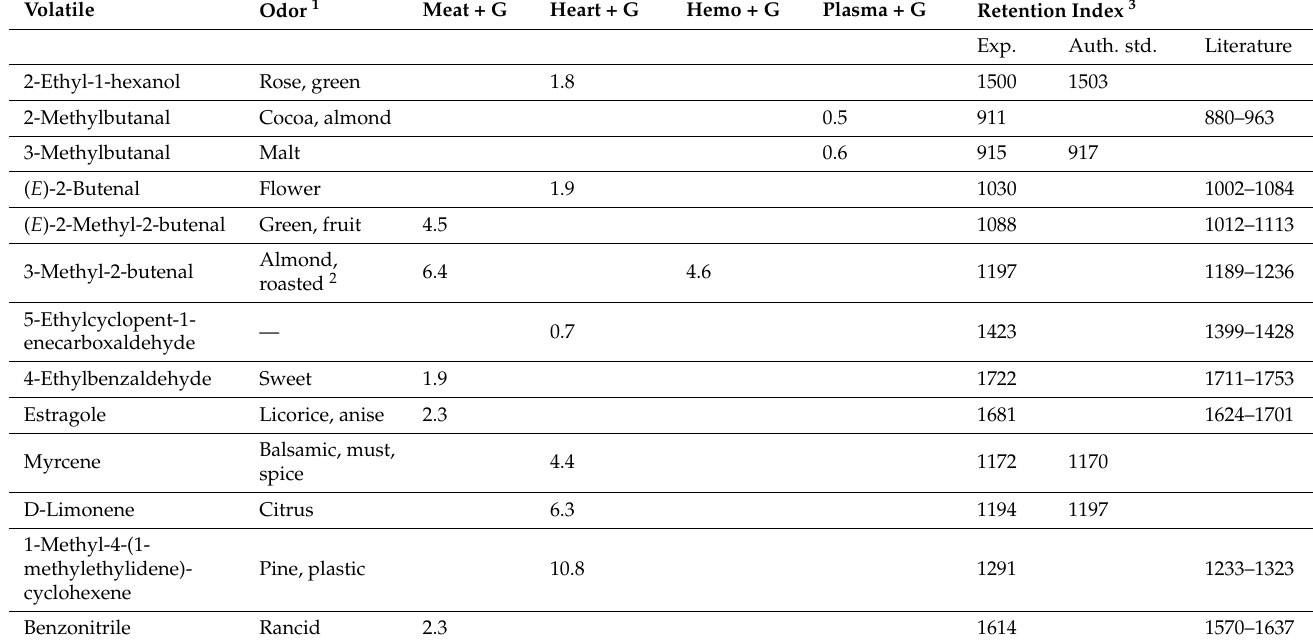
Table 3. Volatile compounds where glucosamine (G) addition had an effect on quantities present in the hydrolysates. Relative quantity in hydrolysate without glucosamine is set to 1, and hydrolysate + G is indicated as fold